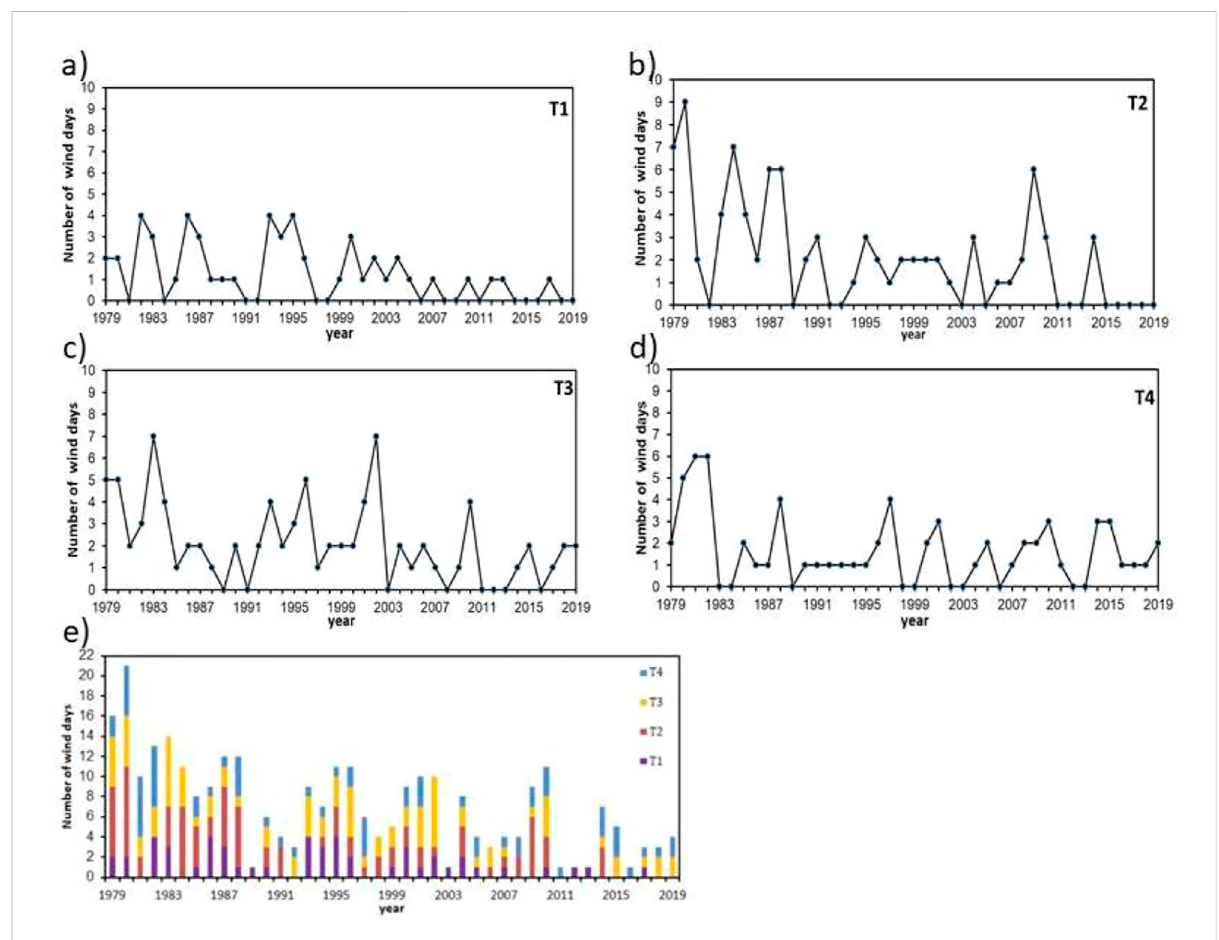
FIGURE 7 Same as Figure 2 but for (A) T1, (B) T2, (C) T3 and (D) T4 categories. (E) quantitative differences among each